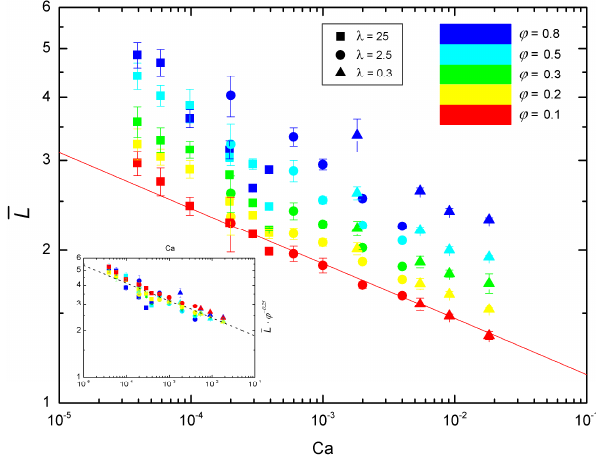
Figure 3. Dimensionless droplet length as a function of the capillary number of the continuous phase Ca for three aqueous solutions characterized by different viscosity ratios λ with the dispersed phase (linseed oil): λ = 25, water (full squares), λ = 2.5, 60% ( w / w ) glycerol/water (full dots), and λ = 0.3, 85% ( w / w ) glycerol/water (full triangles). The colors refer to different ratios of the flow rates φ . Inset: dimensionless droplet length, L , normalized to φ 0.25 as a function of